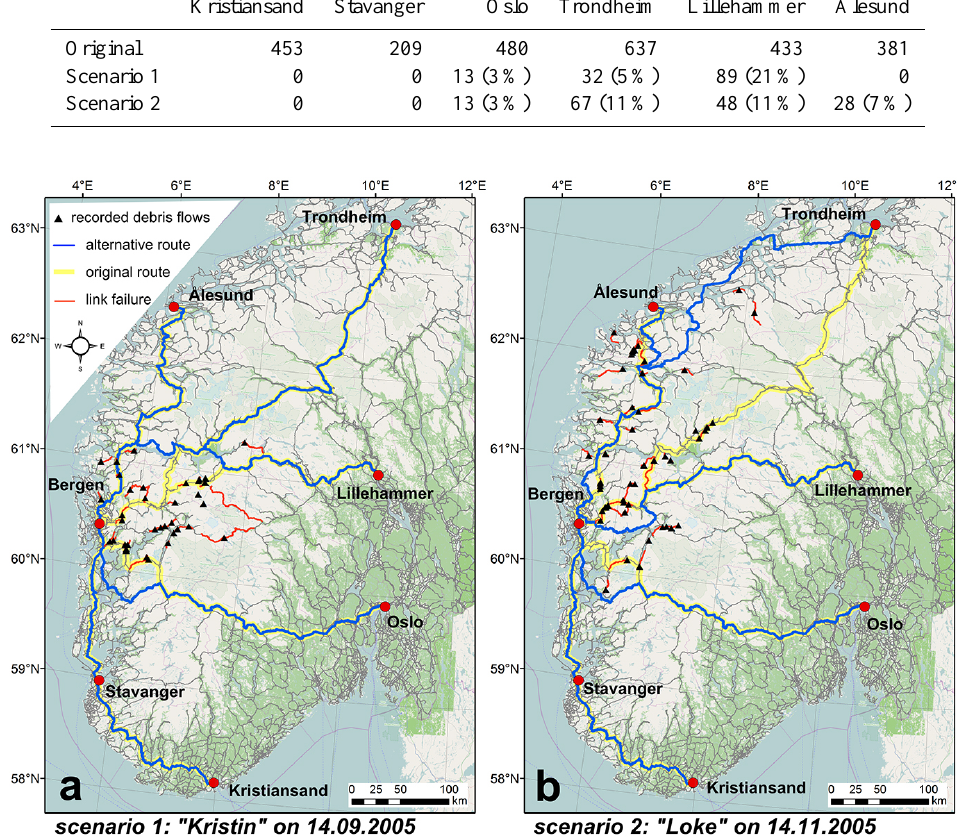
Figure 9. Scenarios investigating effects of extreme rainfall events (a) “Kristin” and (b) “Loke” in 2005 and related debris flows along routes between Bergen and other large cities in southern